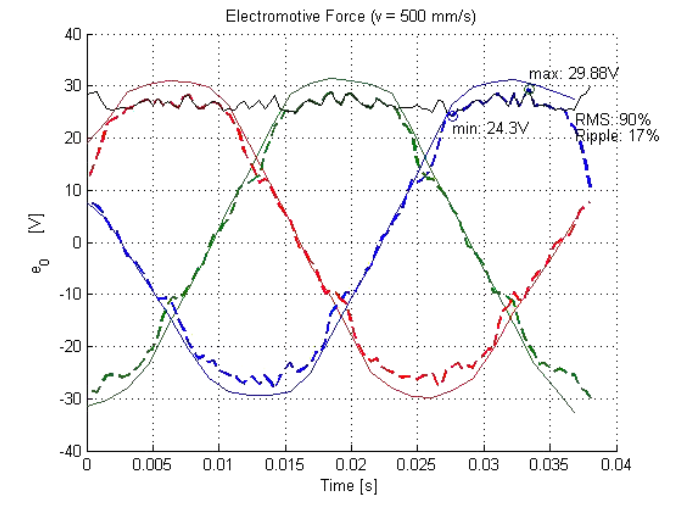
Figure 11. Trend of the Electromotive Force in the three phases of TPM-LiG: the predicted (thin lines) compared with the measured (bold lines). The black line represents the trend of output voltage if a Graetz rectifier is used with a double three-phase